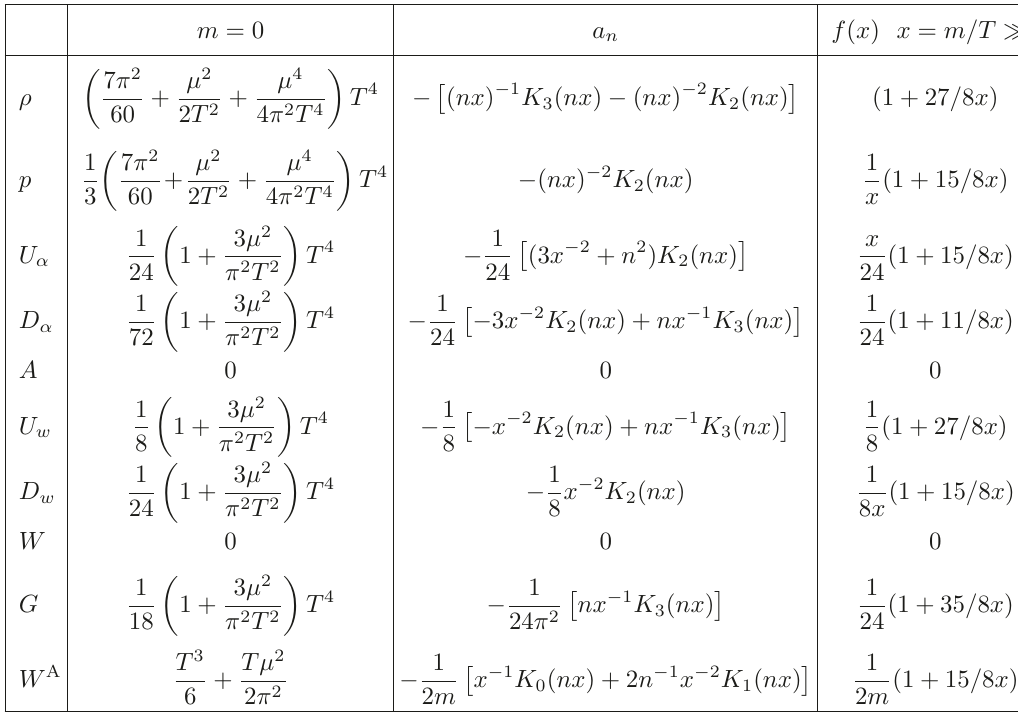
Table 2 . The stress-energy tensor coefficients (5.3) for a free Dirac field: the first column